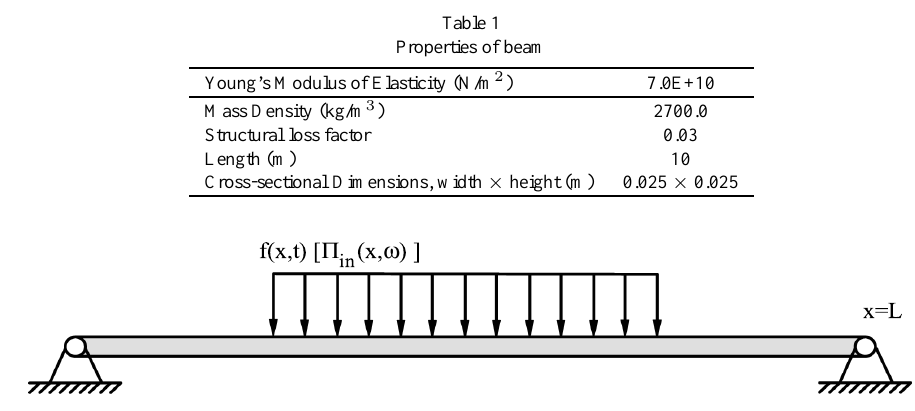
Fig. 1. A simply supported beam subject to distributed random